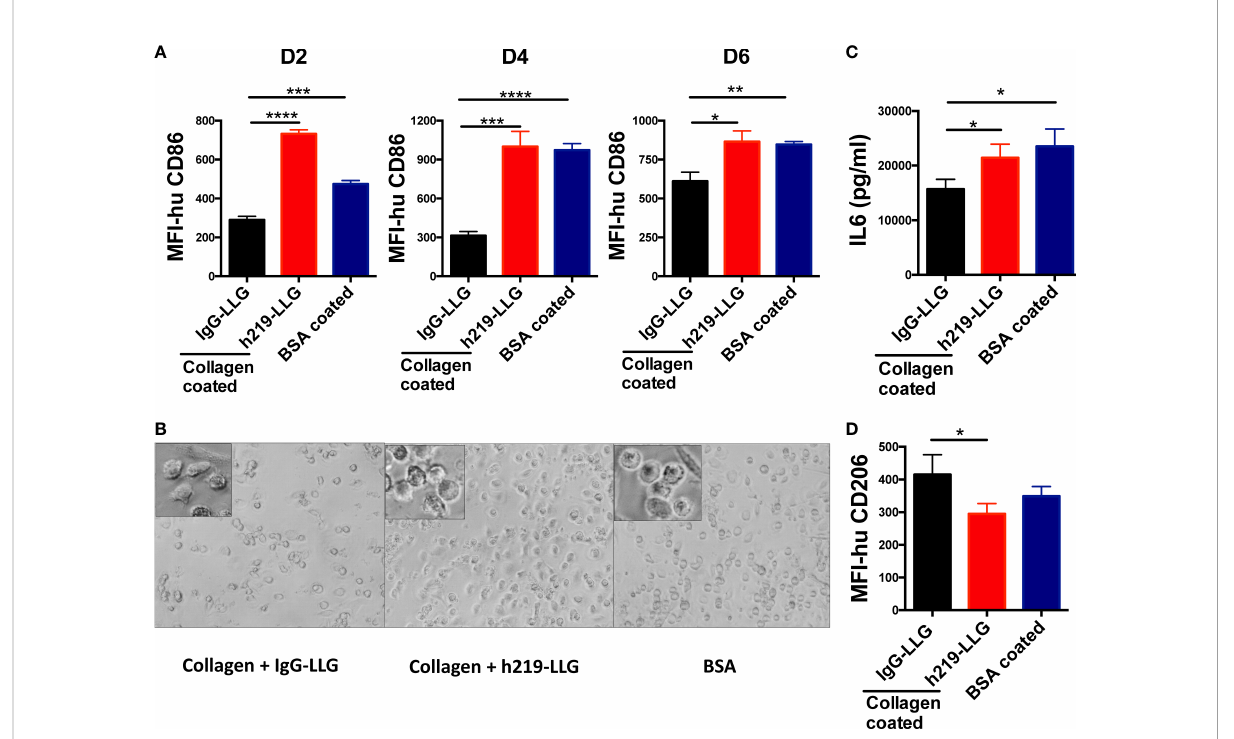
FIGURE 3 Inhibition of LAIR1 promotes differentiation and cytokine secretion of in vitro differentiated human macrophages. (A, B) M1 macrophages were in vitro differentiated from CD14 + monocytes isolated from fresh human PBMCs. Cells were treated with collagen-1 and antibodies from day 0 when differentiation started. MFI of CD86 was detected on day 2, 4, and 6 (A) . Morphology of cells on day 4 (B) . (C) M0 macrophages were polarized with IFN- g and LPS, meanwhile treated with collagen-1 and antibodies. IL6 in supernatant was determined at 48 hours after polarization. (D) M2a macrophages were in vitro differentiated from CD14 + monocytes isolated from fresh human PBMCs. Collagen-1 and antibodies were included in the differentiation from day 0. MFI of CD206 was detected on day 8, when was 1 day after polarization. As the Statistical Analysis section of Methods describes, * indicates p < 0.05; ** indicates p *< 0.01, *** indicates p < 0.001, **** indicates p <